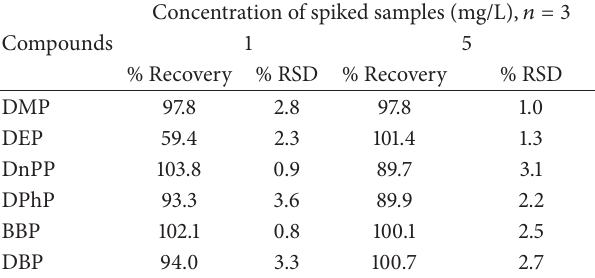
Table 4: Effect of the extraction solvent on phthalate recovery. Compounds